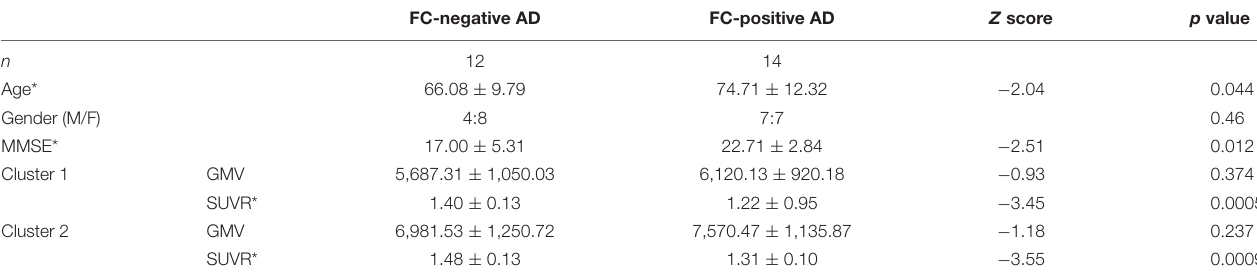
TABLE 4 | Demographic and radiological characteristics of the FC-positive and FC-negative groups in AD patients. FC-negative AD FC-positive AD Z